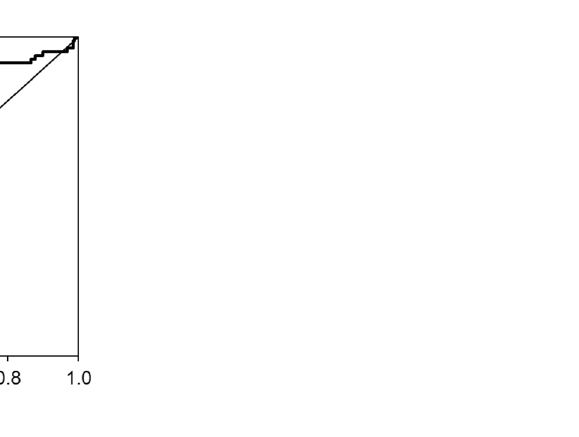
Figure 1. ROC curves for prediction of the primary endpoint (i.e., the two-year prognosis in terms of all-cause mortality, heart transplantation, LVAD implantation).